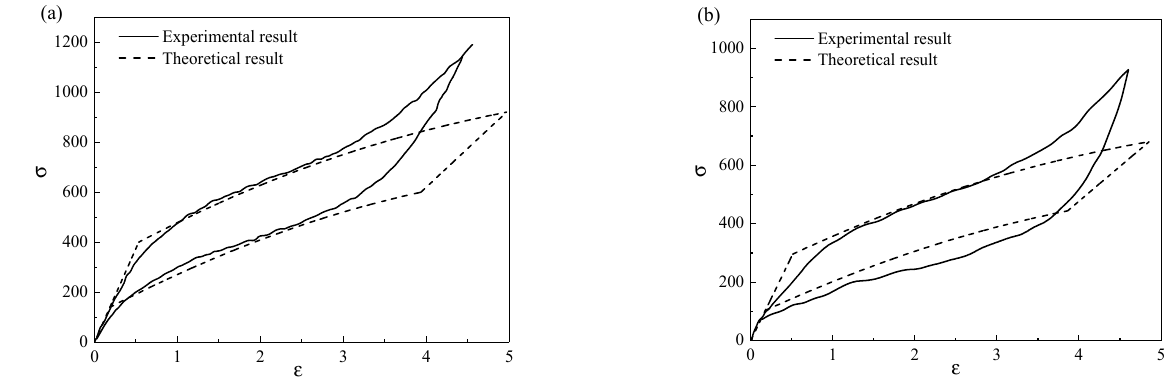
= mum strain was the largest when 0.1 r , but there was little difference in the other three cases. Thus, the pore shape had a great impact on the stress–strain relationship of the po- rous SMA.